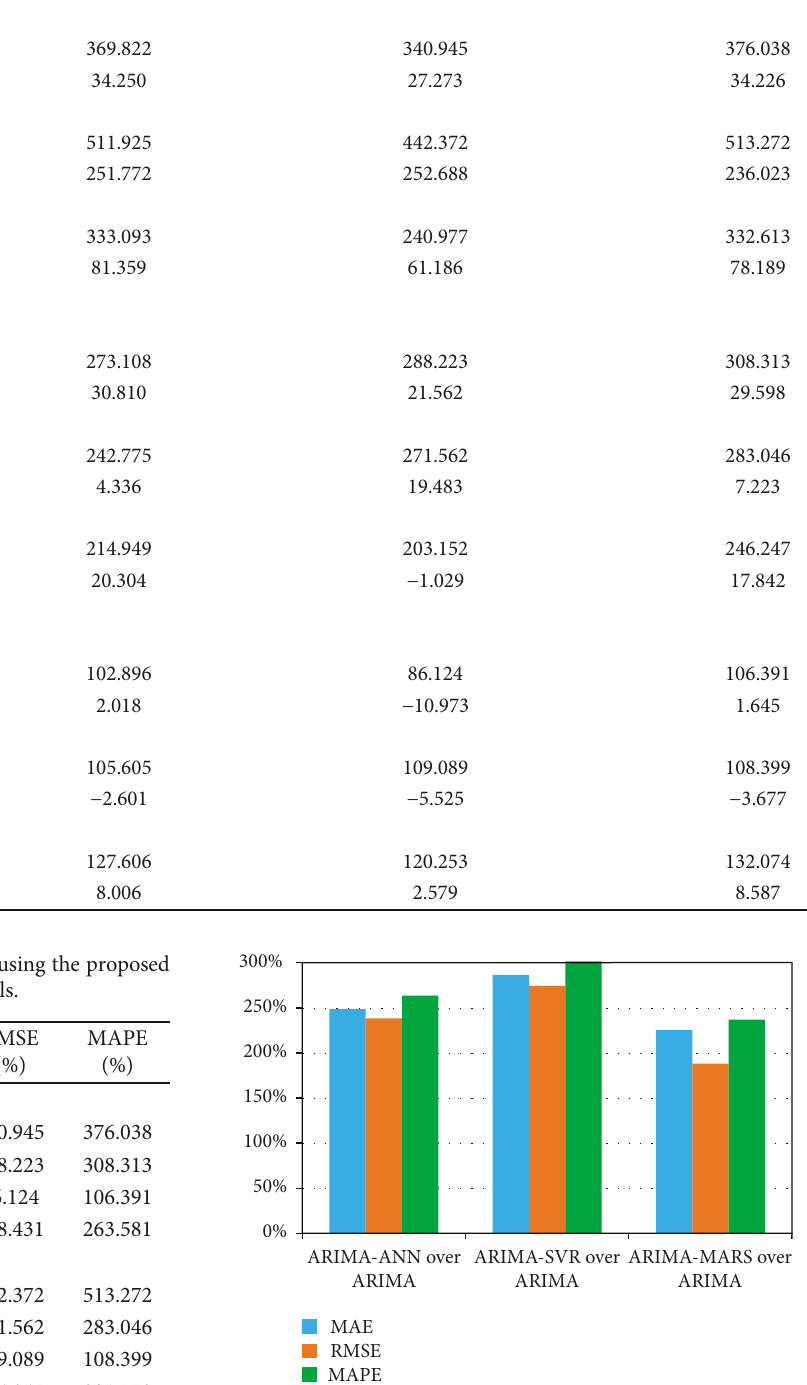
Figure 4: Average PIs by using the proposed integrated models over single ARIMA